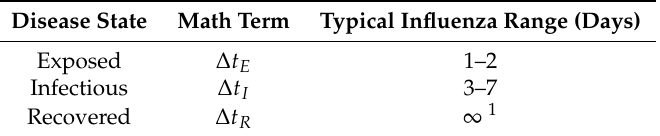
Figure 1. The four states of a basic Susceptible-Exposed-Infectious-Recovered (SEIR) disease model. ( ∆ t E ), ( ∆ t I ), and ( ∆ t R ) show the dwell times in exposed, infectious, and recovered states, respectively. The model can be used to describe (SIR), susceptible-infectious-susceptible (SIS) and susceptible-infectious (SI) disease models. Table 1. Typical influenza ranges for disease state parameters.